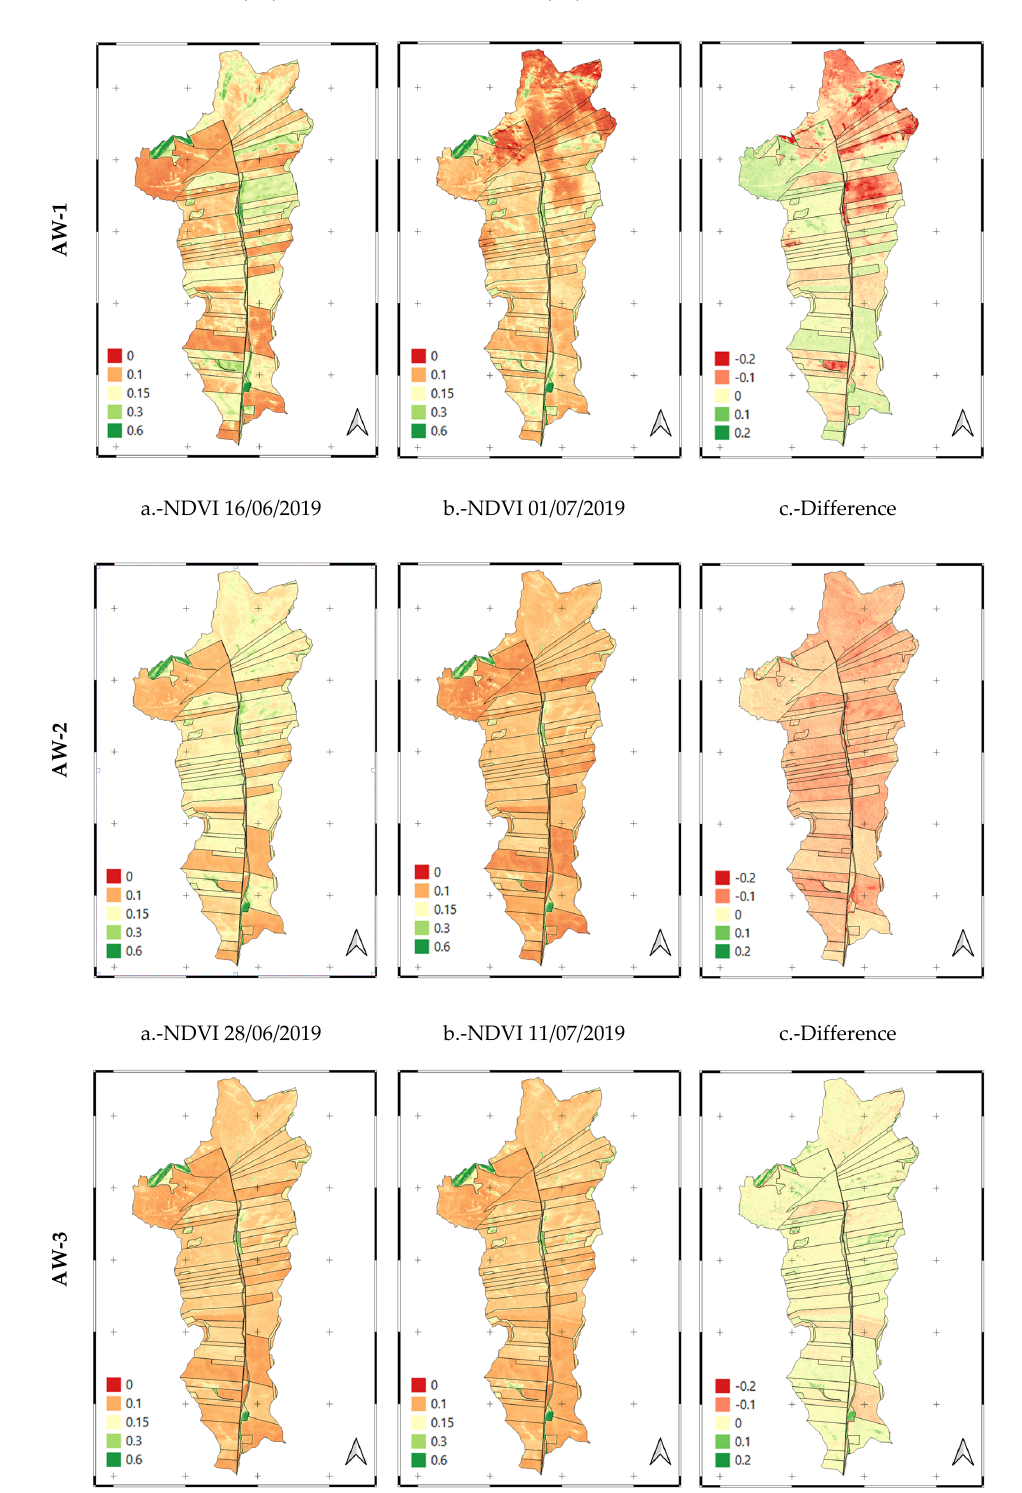
Figure 5. NDVI at the beginning/end of AW-1, AW-2, and AW-3 ( a , b ) and variation ( c ). Zebra frame segments of 1 km.